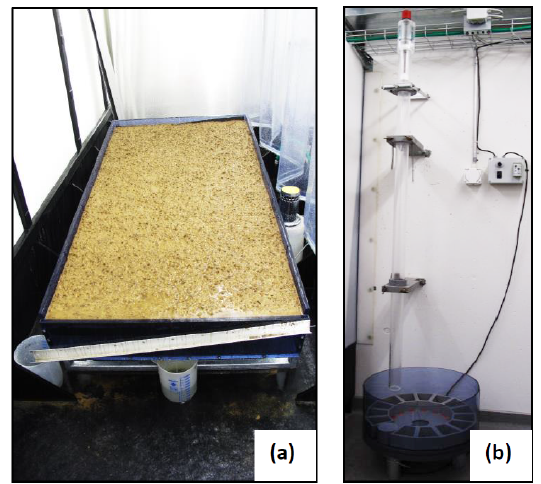
Figure 1. The rainfall simulation flume (a) , and the settling tube apparatus (b) . The settling tube apparatus consists of four compo- nents: the settling tube, through which the soil sample settles; the injection device, by which the soil sample is introduced into the tube; the turntable, within which the fractionated subsamples are collected; and the control panel, which allows an operator to con- trol the rotational speed and rest intervals of the turntable (opera- tions see Hu et al.,